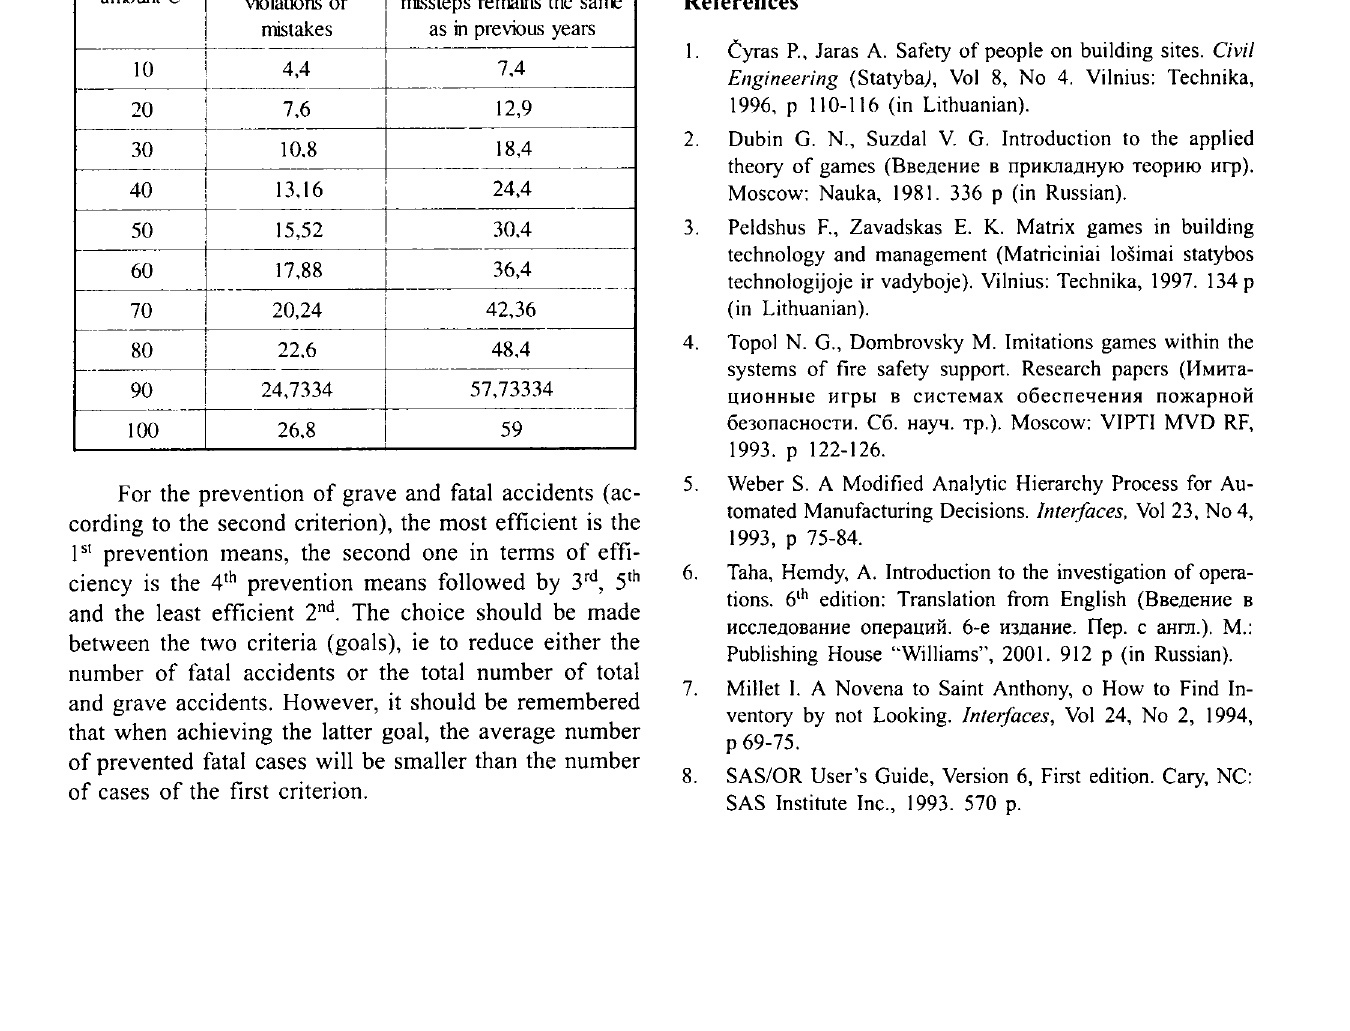
Table 3. Expected decrease of average number of accidents depending on the amount of the funds invested for trauma pre vention ! The expected average number of prevented fatal I and grave accidents achieved due to trauma The invested ! prevention percentage I portion of the